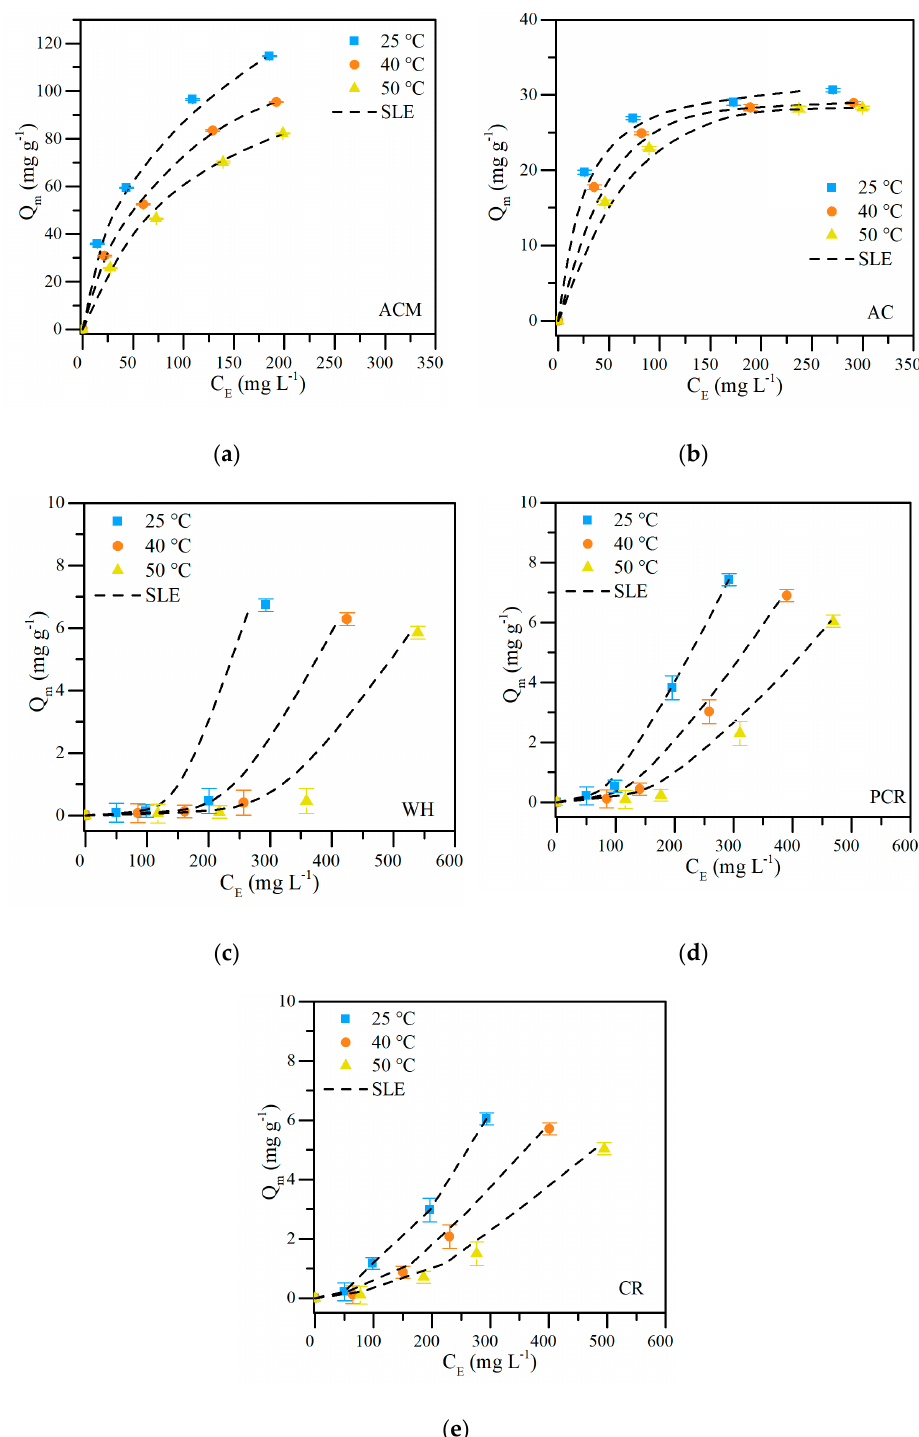
Figure 10. Crude oil adsorption isotherms in ( a ) activated carbon modified with 5.0 wt.% of magnetite nanoparticles (ACM), ( b ) synthesized activated carbon (AC), ( c ) walnut shell (WH), ( d ) pyrolyzed coffee residue (PCR), and ( e ) coffee residue (CR), at different temperatures of 25 ◦ C, 40 ◦ C and 50 ◦ C. pH = 7.1 and the adsorbent dose was 1 g L − 1